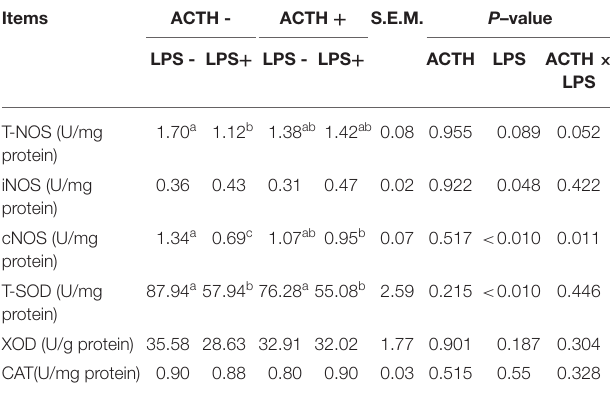
TABLE 1 | Nucleotide sequences of specific primers used in qPCR. Genes Primers